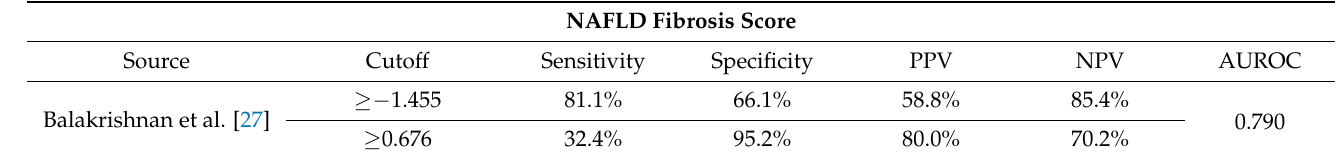
Table 7. Diagnostic accuracy of established scores and biomarkers for detecting advanced